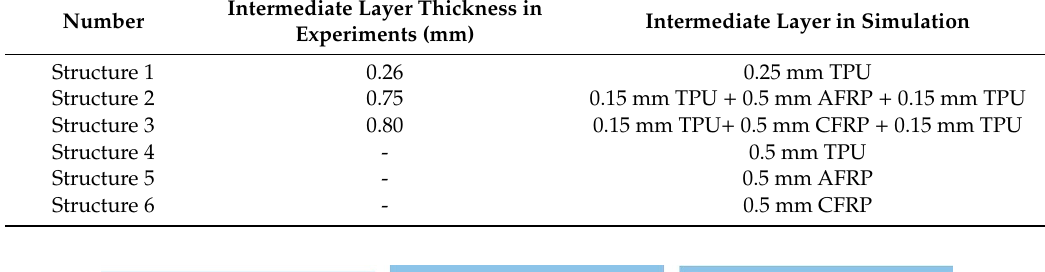
Table 1. Structures’ illustration.